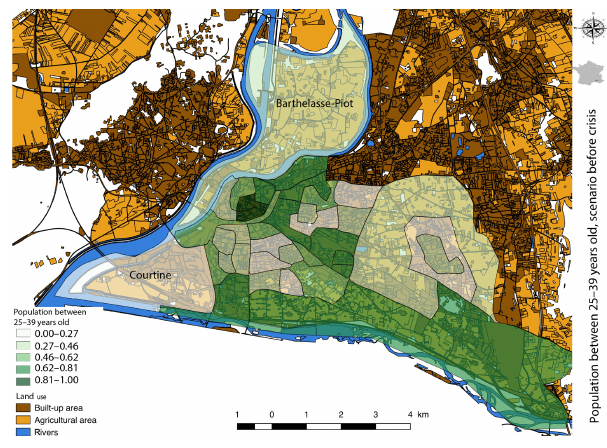
Figure 11. Population between 25- and 39-year-old-scenario before crisis, at the Avignon scale (IRIS-scale analysis). The map identifies the value of the population variable 25–39 years old according to the total IRIS population before a crisis – © Open Database License, “ODbL”